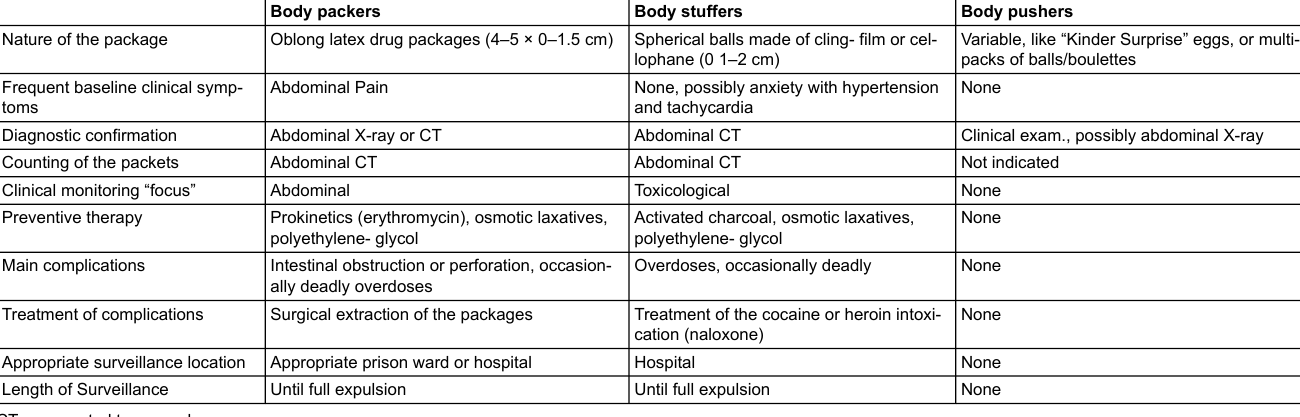
Table 3: Characteristics of and recommendations for the management of body packers, body stuffers and body pushers Body packers Body stuffers Body pushers Nature of the